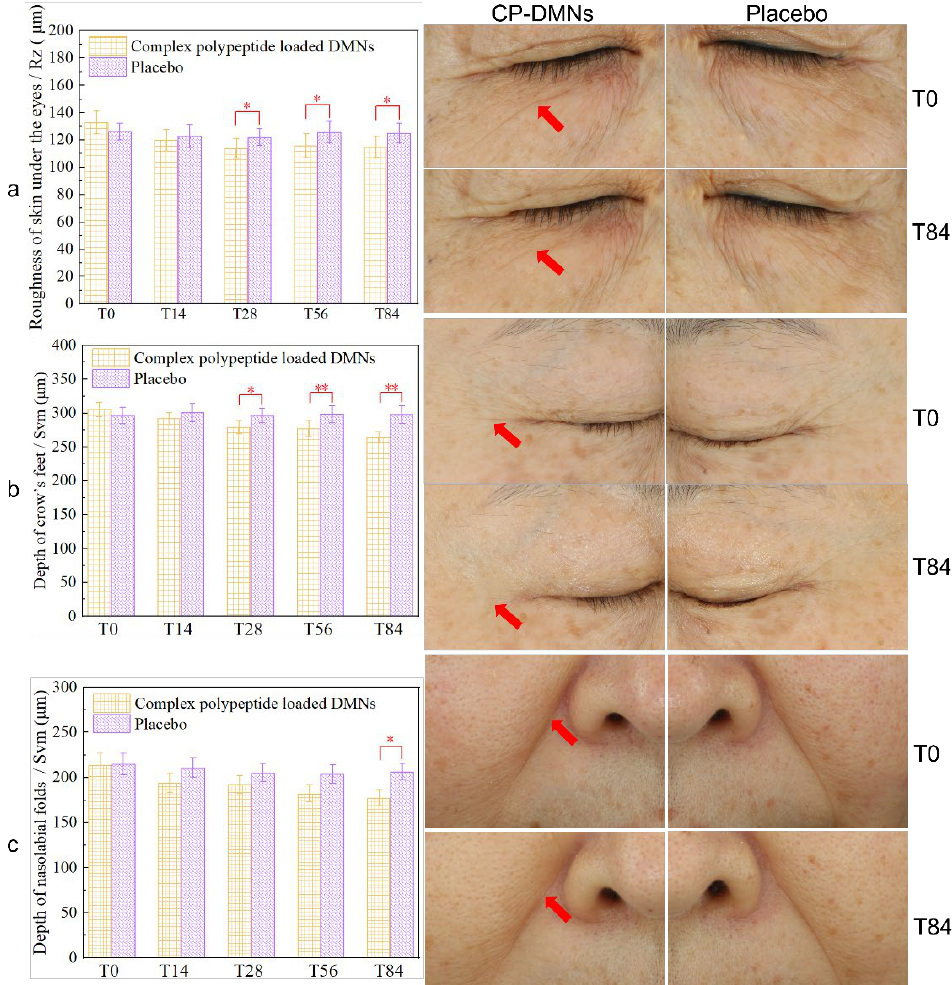
Figure 5. The results of the wrinkles profilometry and standard imaging based on under-eye fine lines ( a ), crow’s feet ( b ), and nasolabial folds ( c ) between CP-DMNs and placebo (blank DMNs). The significant threshold of p < 0.05 and p < 0.01 are marked with *and **, respectively.